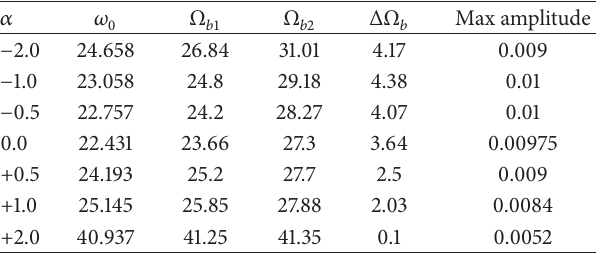
Figure 8: Comparison between the frequency responses for differ- ent values of 𝛼 . Table 1: Variation of the inverse fundamental frequency 𝜔 0 and the bifurcation points Ω 𝑏1 and Ω 𝑏2 with respect to 𝛼